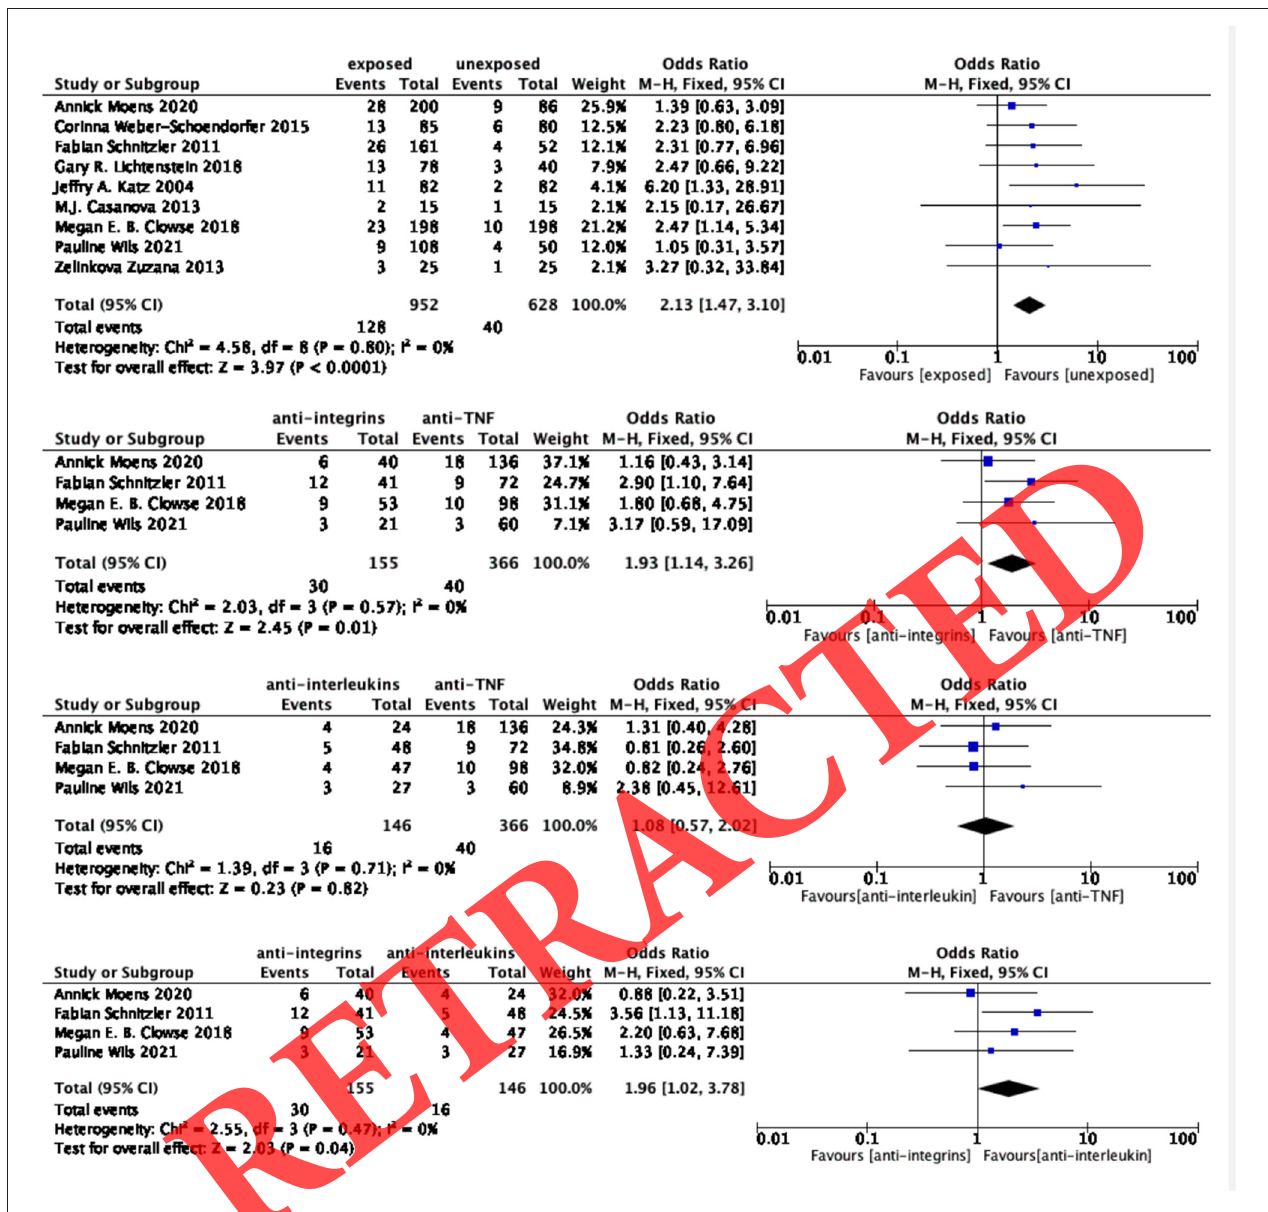
FIGURE 4 | Risk of spontaneous abortion in pregnant women treated with biologics for